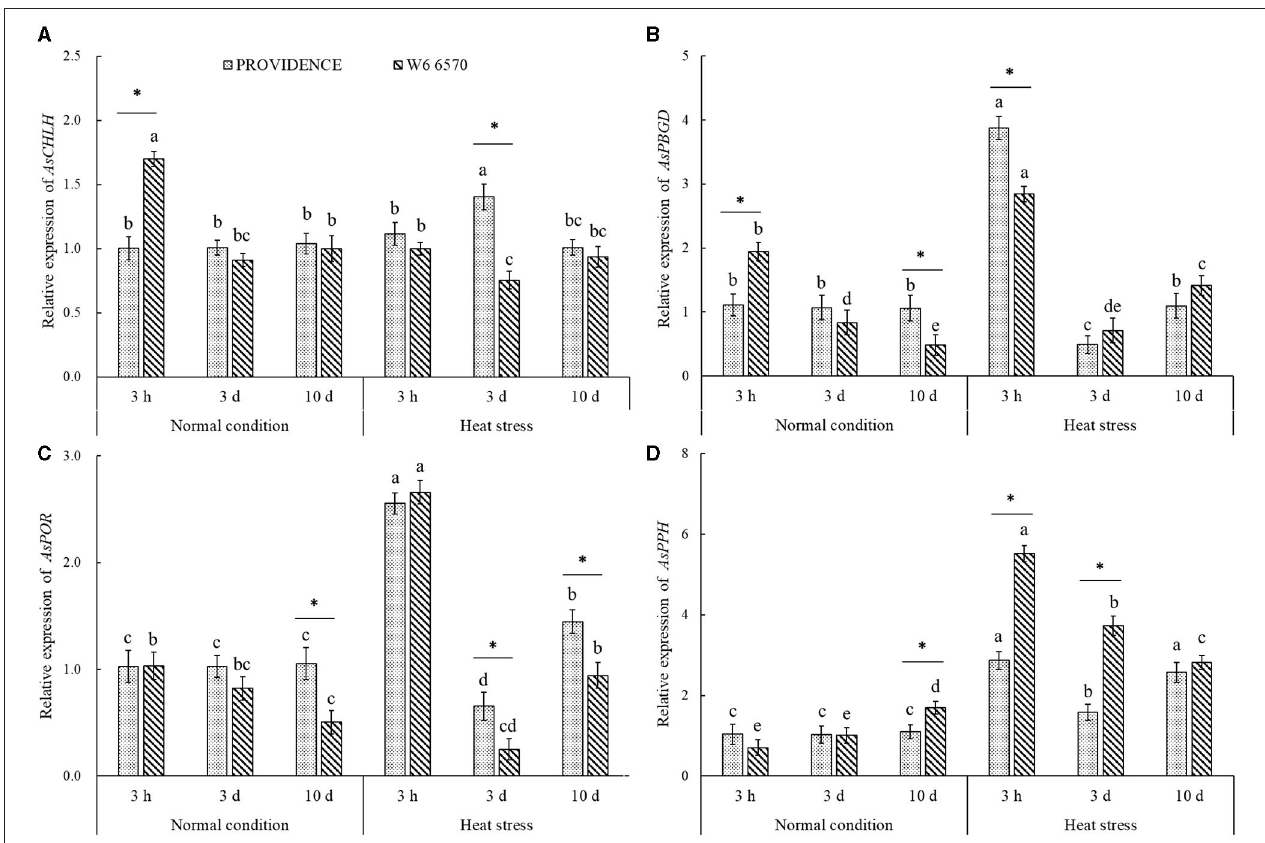
FIGURE 4 | Changes in transcript levels of (A) AsCHLH , (B) AsPBGD , (C) AsPOR , and (D) AsPPH in leaves of two creeping bentgrass materials (PROVIDENCE and W6 6570) during heat stress (38/33 ◦ C, day/night) in controlled growth chambers. Vertical bars indicate ± SE of mean ( n = 4). Different letters above column indicate significant differences ( P ≤ 0.05) in a particular material (PROVIDENCE or W6 6570) under normal conditions and heat stress. The asterisk “*” indicates significant differences ( P ≤ 0.05) between PROVIDENCE and W6 6570 at one specific time point (3h, 3 days, or 10